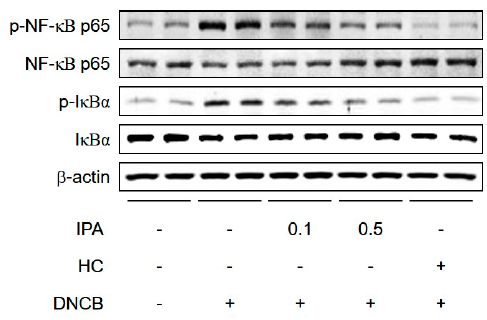
Figure 5. Inhibitory effect of IPA on DNCB-induced NF- κ B activation in BALB/C mice. Protein levels of p-NF- κ B p65, p-I κ B α , I κ B α , and β -actin were determined by Western blotting.